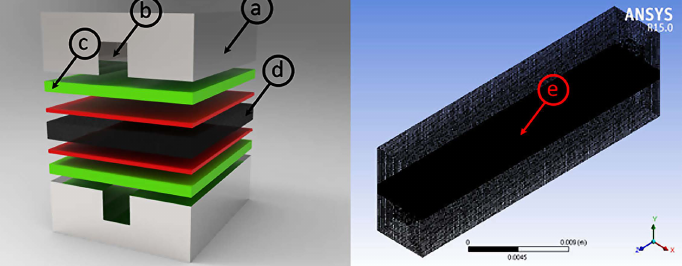
Figure 1. 3D model of different parts of PEMFC: ( a ) Current flow channel; ( b ) Cathode and anode gas channel; ( c ) GDL; ( d ) Membrane; ( e ) 3D mesh model for numerical simulation.